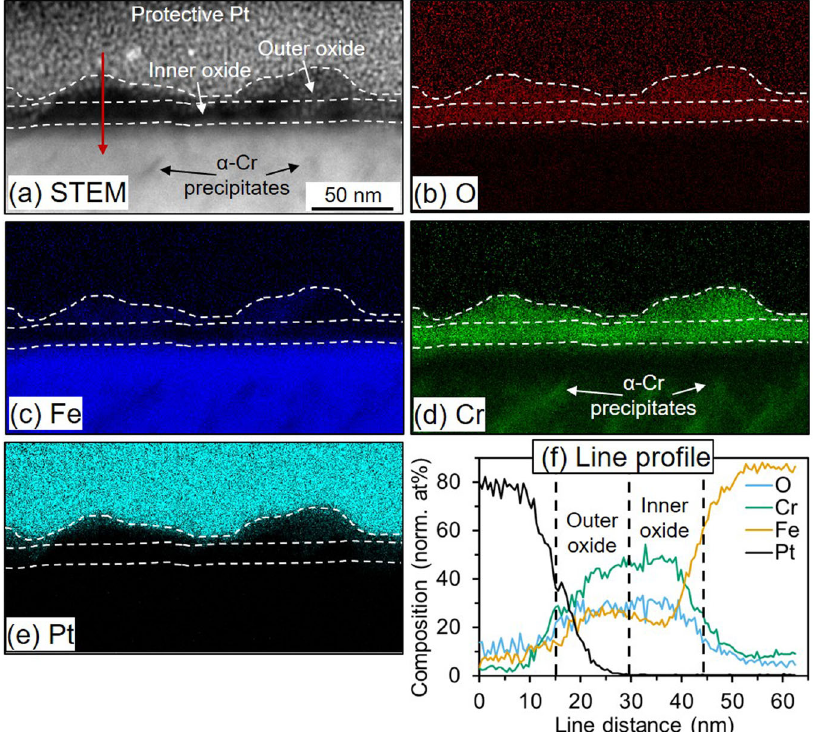
Fig. 5 Cross-sectional STEM/EDS analysis of Fe22Cr after AP-XPS in high purity CO 2 . a STEM image of the oxidized surface. b – e Corresponding EDS maps showing elements of interest. f EDS line pro fi le taken along the red line shown in a